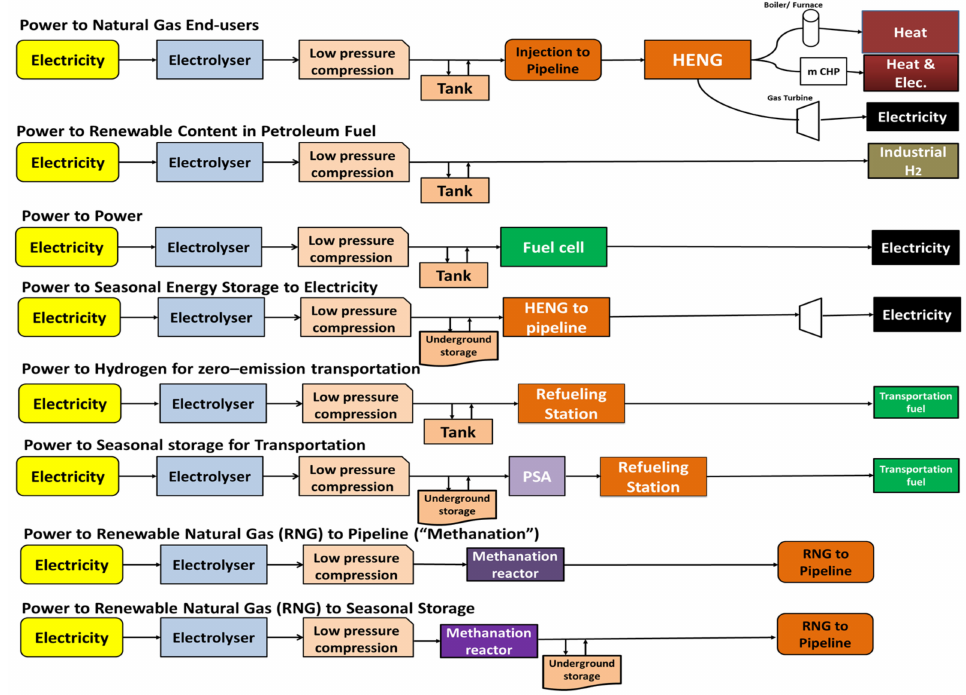
Figure 2. Different Power-to-gas pathways. Table 5. Energy efficiency comparison of the different Power-to-gas (P2G)